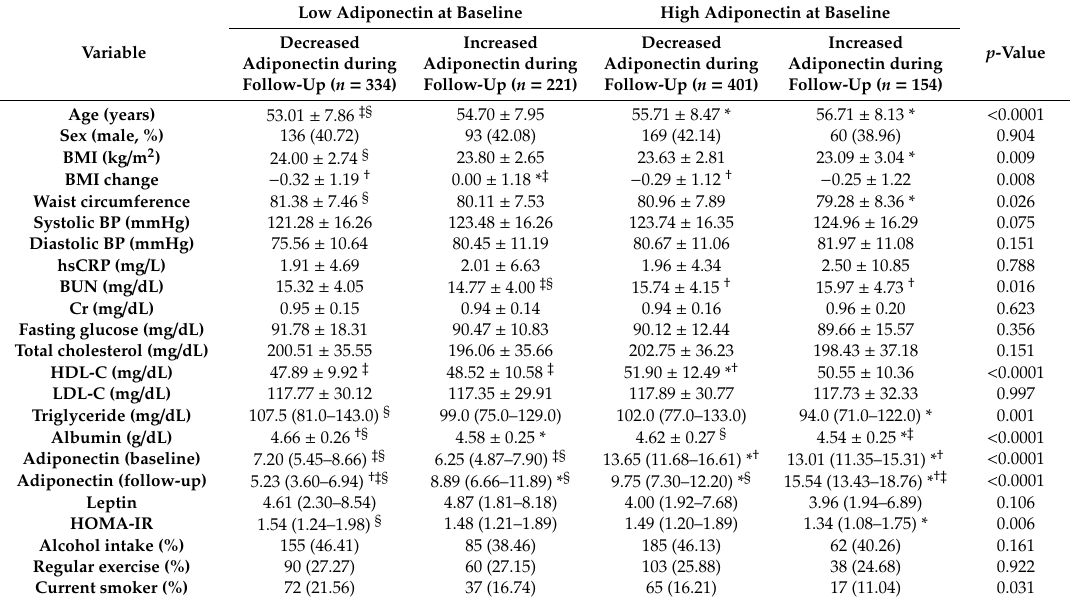
Table 1. Baseline characteristics of participants according to median of plasma adiponectin at baseline and change of plasma adiponectin during follow up period. Low Adiponectin at Baseline High Adiponectin at Baseline Decreased Increased Increased p -Value Variable Decreased Adiponectin during Adiponectin during Adiponectin during Adiponectin during Follow-Up ( n = 154) Follow-Up ( n = 401) Follow-Up ( n = 334) Follow-Up ( n = 221) Age